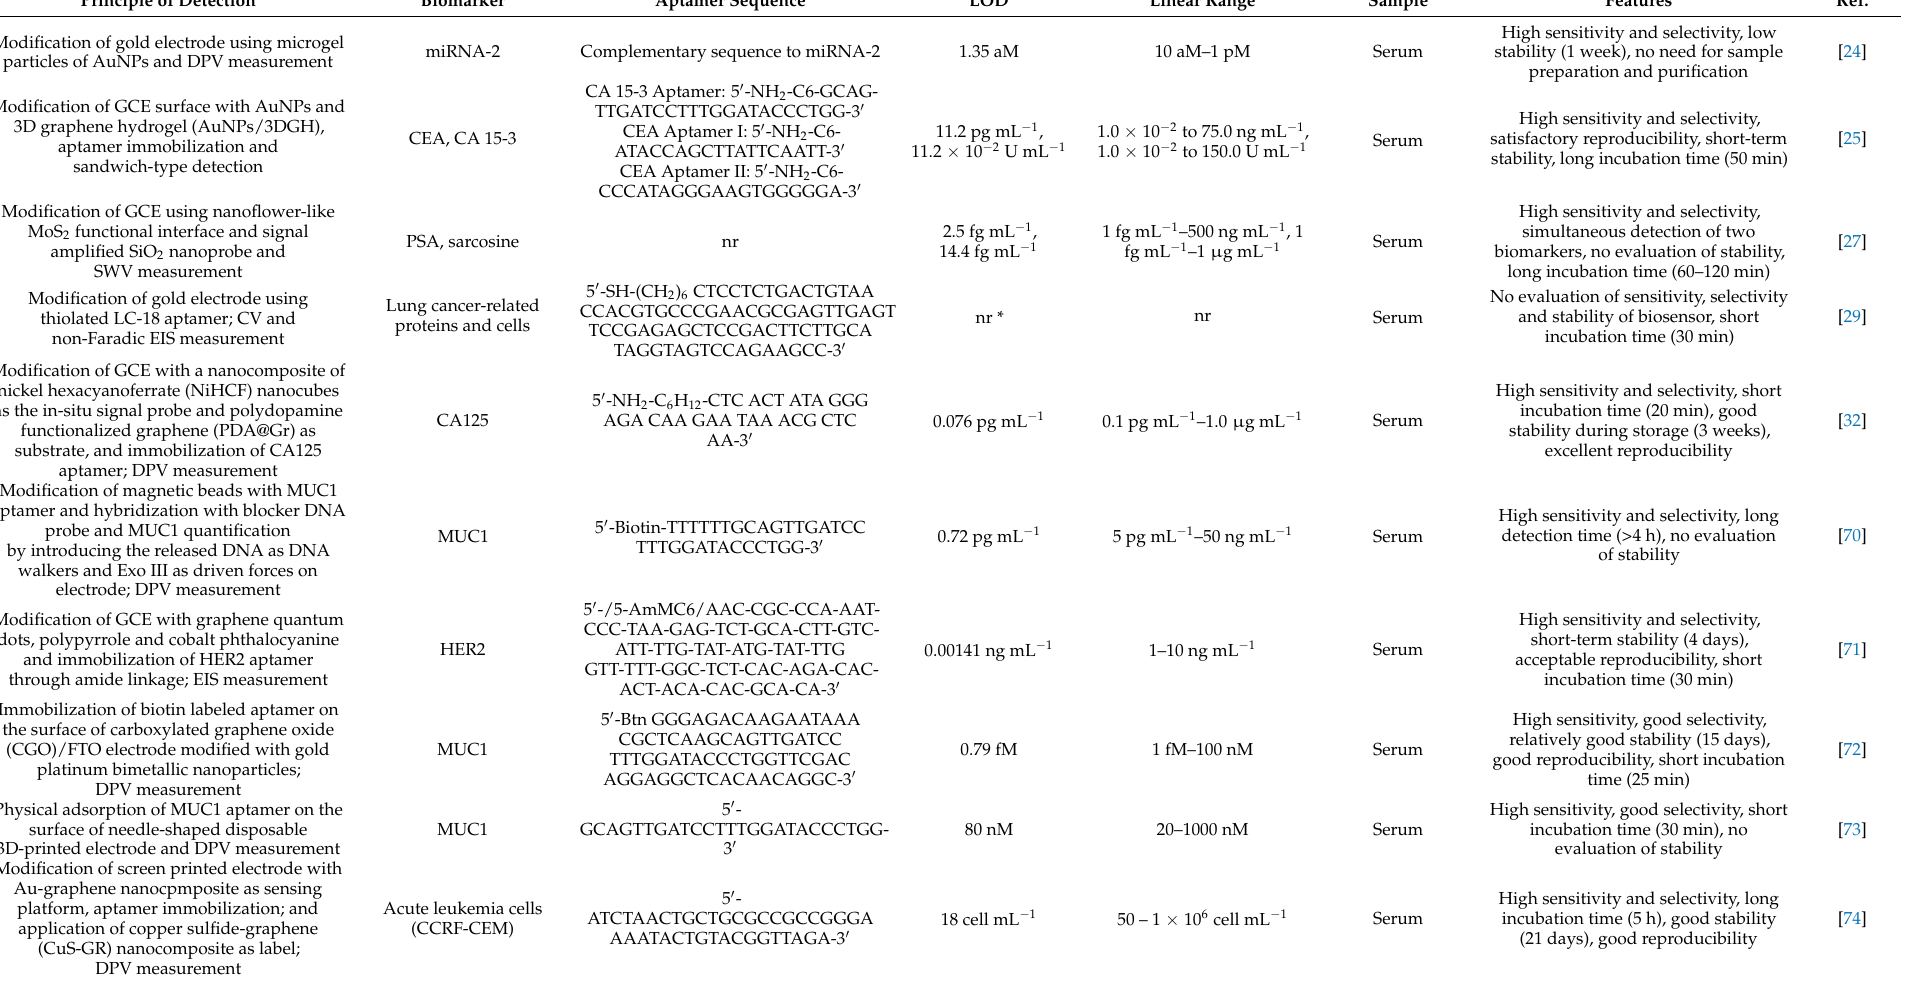
Table 1. Recent advances in electrochemical aptasensors for the detection of cancer